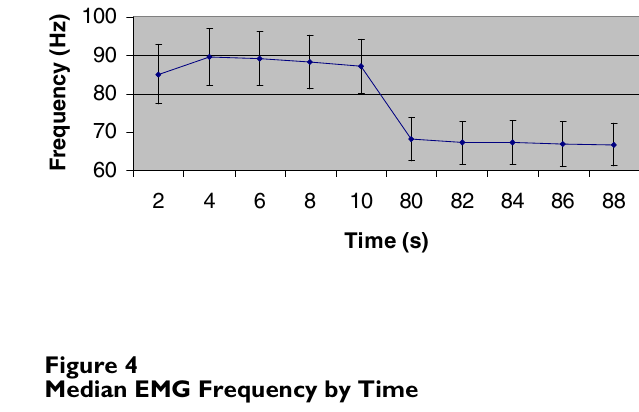
Figure 4 Median EMG Frequency by Time